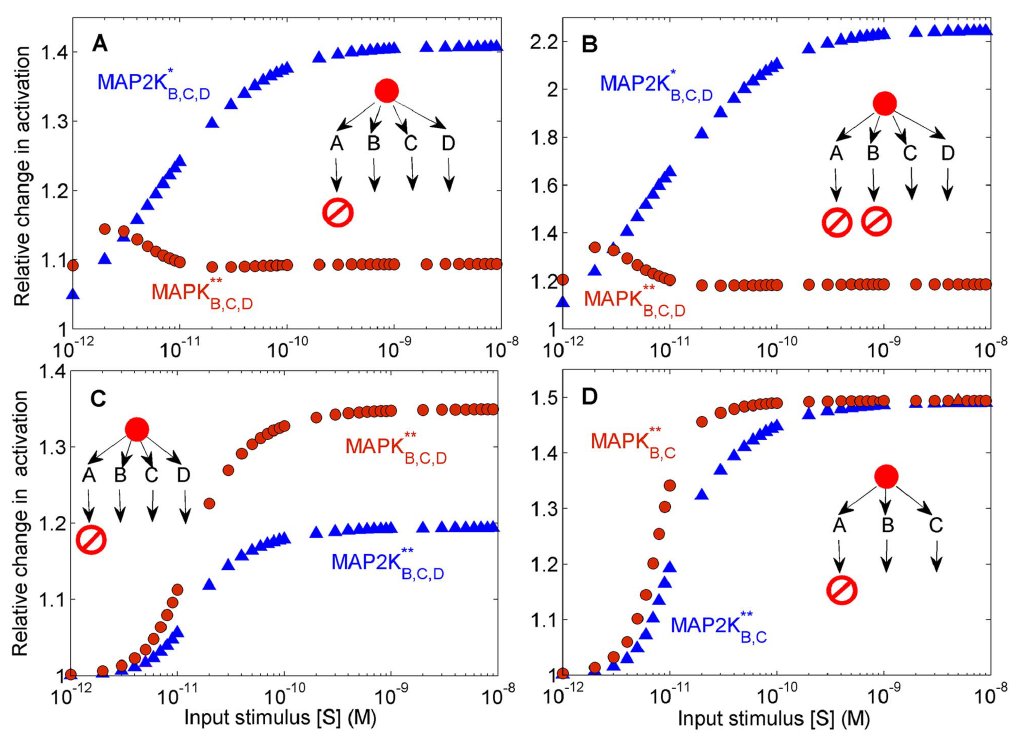
Figure 8. Effect of multiple branches. (A–B) Relative increase in steady-state response in a four -branch cascade which allows only single phosphorylation of MAP2K while MAPK is doubly phosphorylated as a function of stimulus strength for the cases (A) when MAPK A phosphorylation is prevented and (B) when phosphorylation of in two branches, i.e., of both MAPK A and MAPK A , are blocked. The effect of having four branches but with singly phosphorylated MAP2K is similar to having two branches with double phosphorylated MAP2K but with a lower relative change in the response. This suggests that competitive inhibition is playing a role but is not solely responsible for the retrograde propagation in the branched cascade model. (C–D) Relative increase in steady-state response of doubly phosphorylated MAP2K and MAPK in the unperturbed branches as a function of signal strength when phosphorylation of MAPK A is prevented in a (C) a four -branch and (D) a three -branch cascade. As the number of branches are increased, the relative change in MAP2K activity on perturbation decreases faster than that of